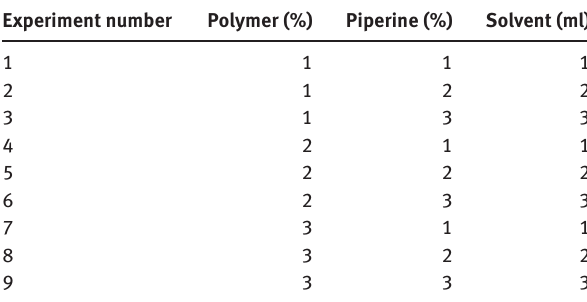
orthogonal array of experiment for preparing Table 2: Taguchi’s L 9 piperine-loaded nisoldipine